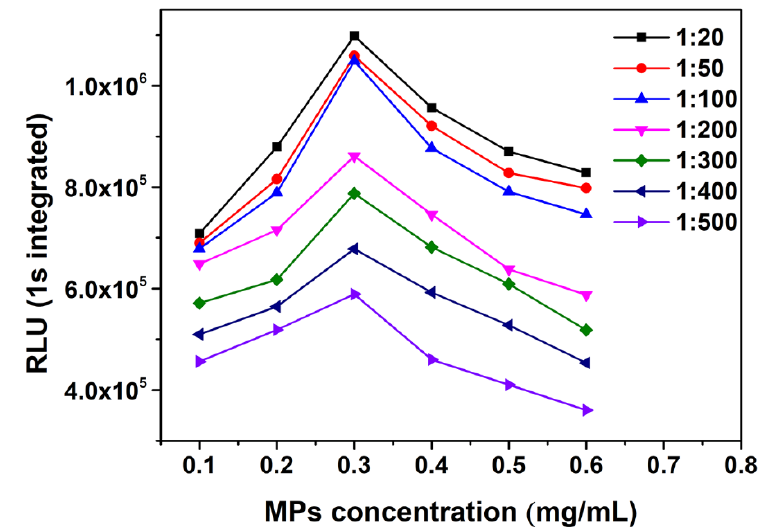
Figure 3. Influence of the dosage of MPs-IgG and the dilution ratio of CmAP-IgG studied using the standard N-terminal pro-B-type natriuretic peptide (NT-proBNP) concentration of 696 ng / L. The seven curves correspond to a series of dilution ratios of CmAP-IgG (i.e., 1:20, 1:50, 1:100, 1:200, 1:300, 1:400 and 1:500). All tests were performed at 37 °C.